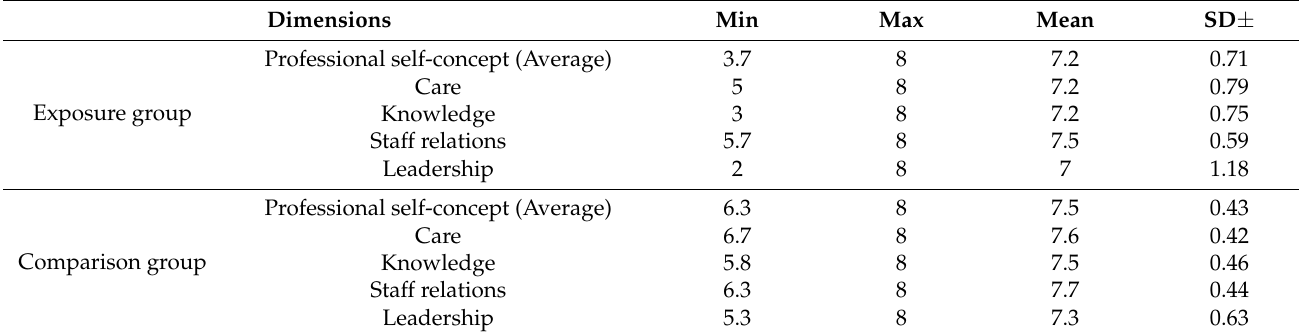
Table 2. Nurses’ professional self-concept and its subdimensions’ scores.